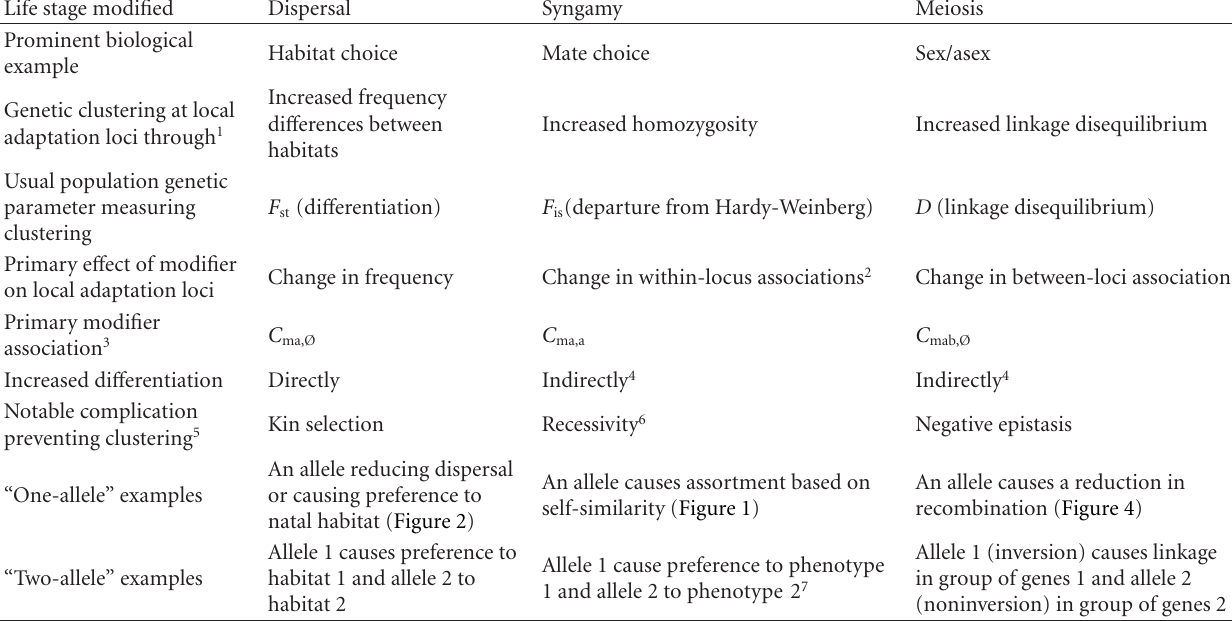
Table 1: Classification of reinforcement mechanisms based on the life stage modified and their consequences on genetic associations involved in genetic clustering. This classification is orthogonal to the one- versus two-allele